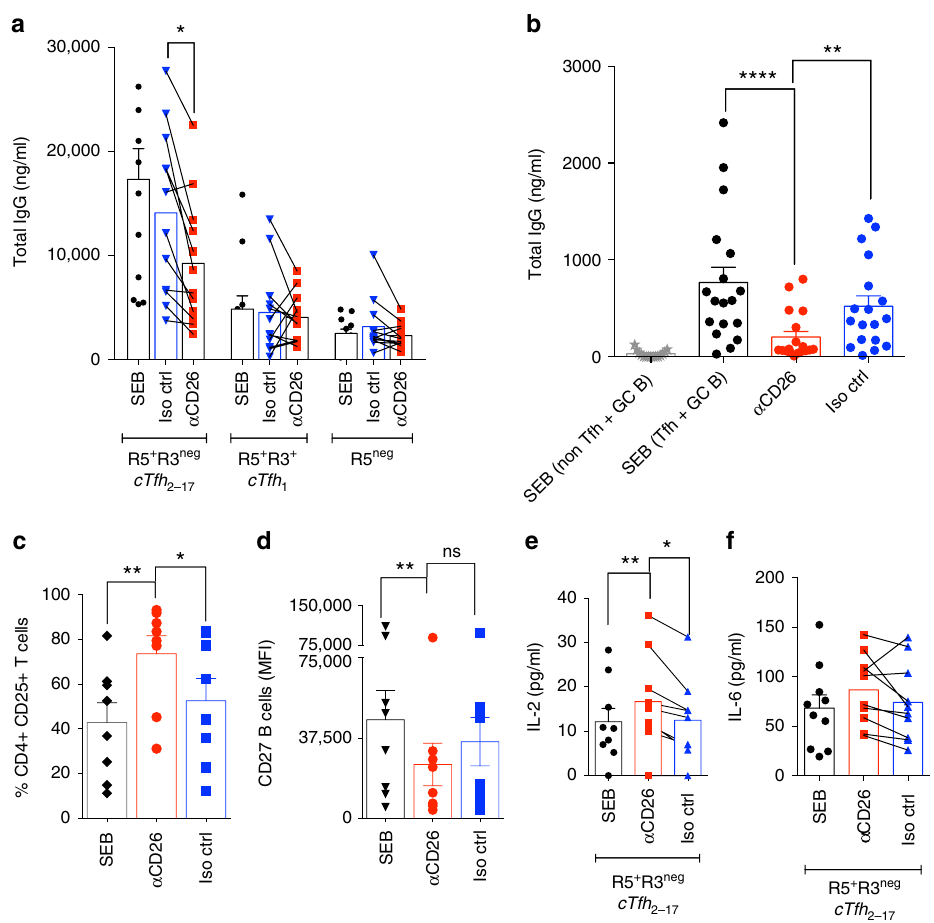
Fig. 6 Targeting CD26 pathway blocks Tfh-mediated helper program. a Production of IgG in supernatants of the 7-day co-cultures of cTfh and non-cTfh with their autologous memory B cells in the presence of anti-CD26 monoclonal anti-human antibody or its isotype control ( n = 12 per group, in four- independent experiments). (ANOVA, paired, two-tailed non-parametric t -test; * p < 0.05, ** p < 0.01; Mean± SEM). b Production of IgG in the supernatants of 5-day co-cultures of GC-Tfh, pre-cTfh and non-Tfh with their autologous GC B in the presence of anti-CD26 monoclonal anti-human antibody or its isotype control ( n = 17, in four-independent experiments). (ANOVA, paired, two-tailed non-parametric t -test; * p < 0.05, ** p < 0.01, *** p < 0.001, **** p < 0.0001; Mean ± SEM). c Generation of memory B cells (CD27 + B cells). d Percentage of CD4 + CD25 + T cells in 7-day co-cultures of cTfh 2-17 with their autologous memory B cells in the presence of anti-CD26 antibody ( n = 8 per group, three-independent experiments). (ANOVA, paired, two-tailed non-parametric t -test; * p < 0.05, ** p < 0.01; Mean± SEM). e Secretion of IL-2 and f secretion of IL-6 in the supernatants of 7-day co-culture of cTfh and non-cTfh with their autologous memory B cells in the presence of anti-CD26 antibody ( n = 9 per group, in two-independent experiments). (ANOVA, paired, two-tailed non-parametric t -test; * p < 0.05, ** p < 0.01; Mean±